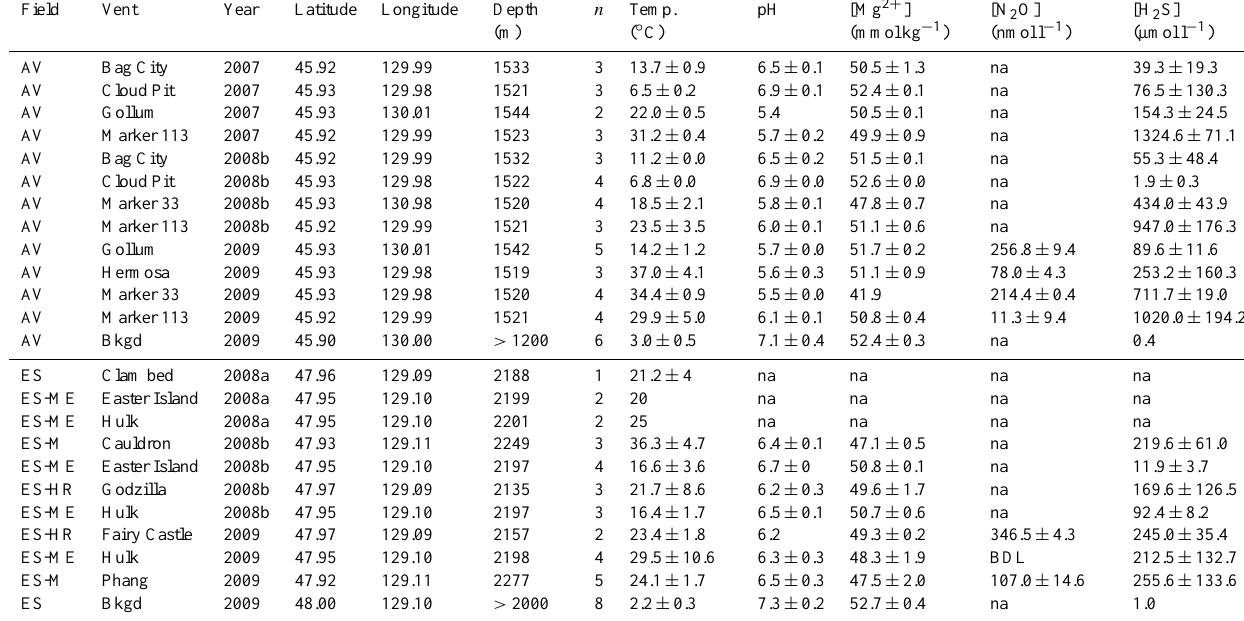
Table 1. Physico-chemical and microbiological properties of the sampled vent fluids at Axial Volcano (AV) and the Endeavour Segment (ES) on the Juan de Fuca Ridge. Values shown are means ± one standard deviation for all samples collected from a given vent on each cruise. 2008a and 2008b refers to samples collected during the June and August–September 2008 cruises,